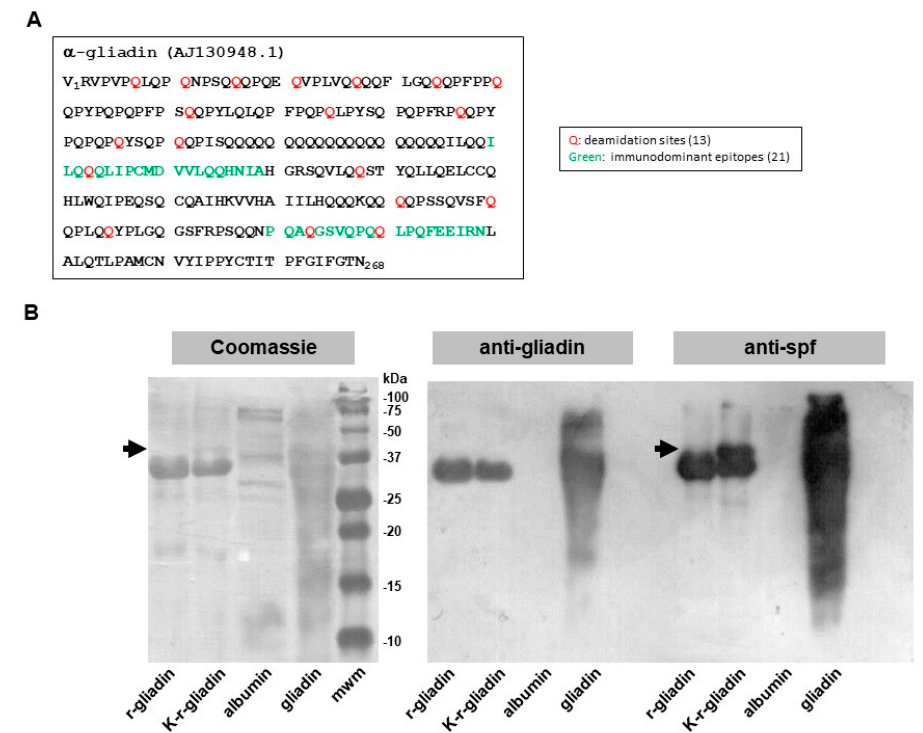
Figure 1. Biochemical characterization of transamidated recombinant α -gliadin. ( A ) Amino acid sequence of the α -gliadin AJ130948.1. The glutamine deamidation sites and the two immunodominant peptides are highlighted in red and green, respectively. ( B ) SDS-PAGE ( left panel ) and Western blot analysis of recombinant α -gliadin (r-gliadin) and its transamidated form (K-r-gliadin) using anti-native gliadin ( middle panel ) or anti-spf mouse polyclonal antibody probes ( right panel ). The arrows indicate the additional band in K-r-gliadin sample.